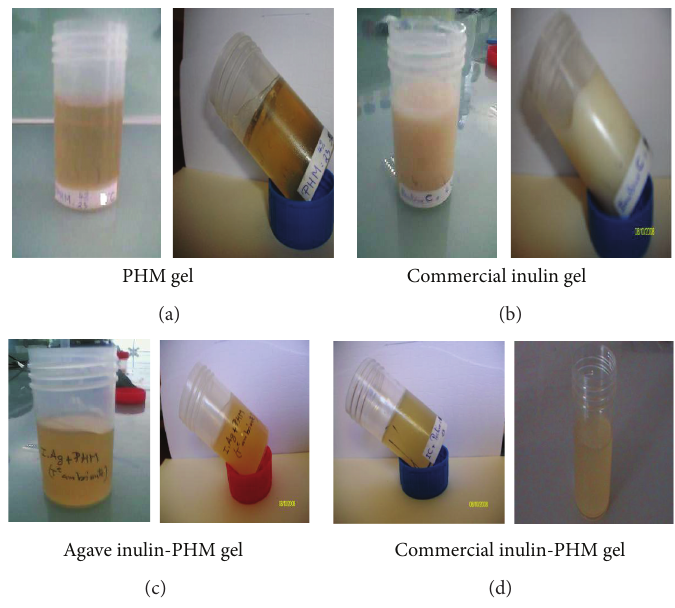
Figure 5: Different prepared gels in